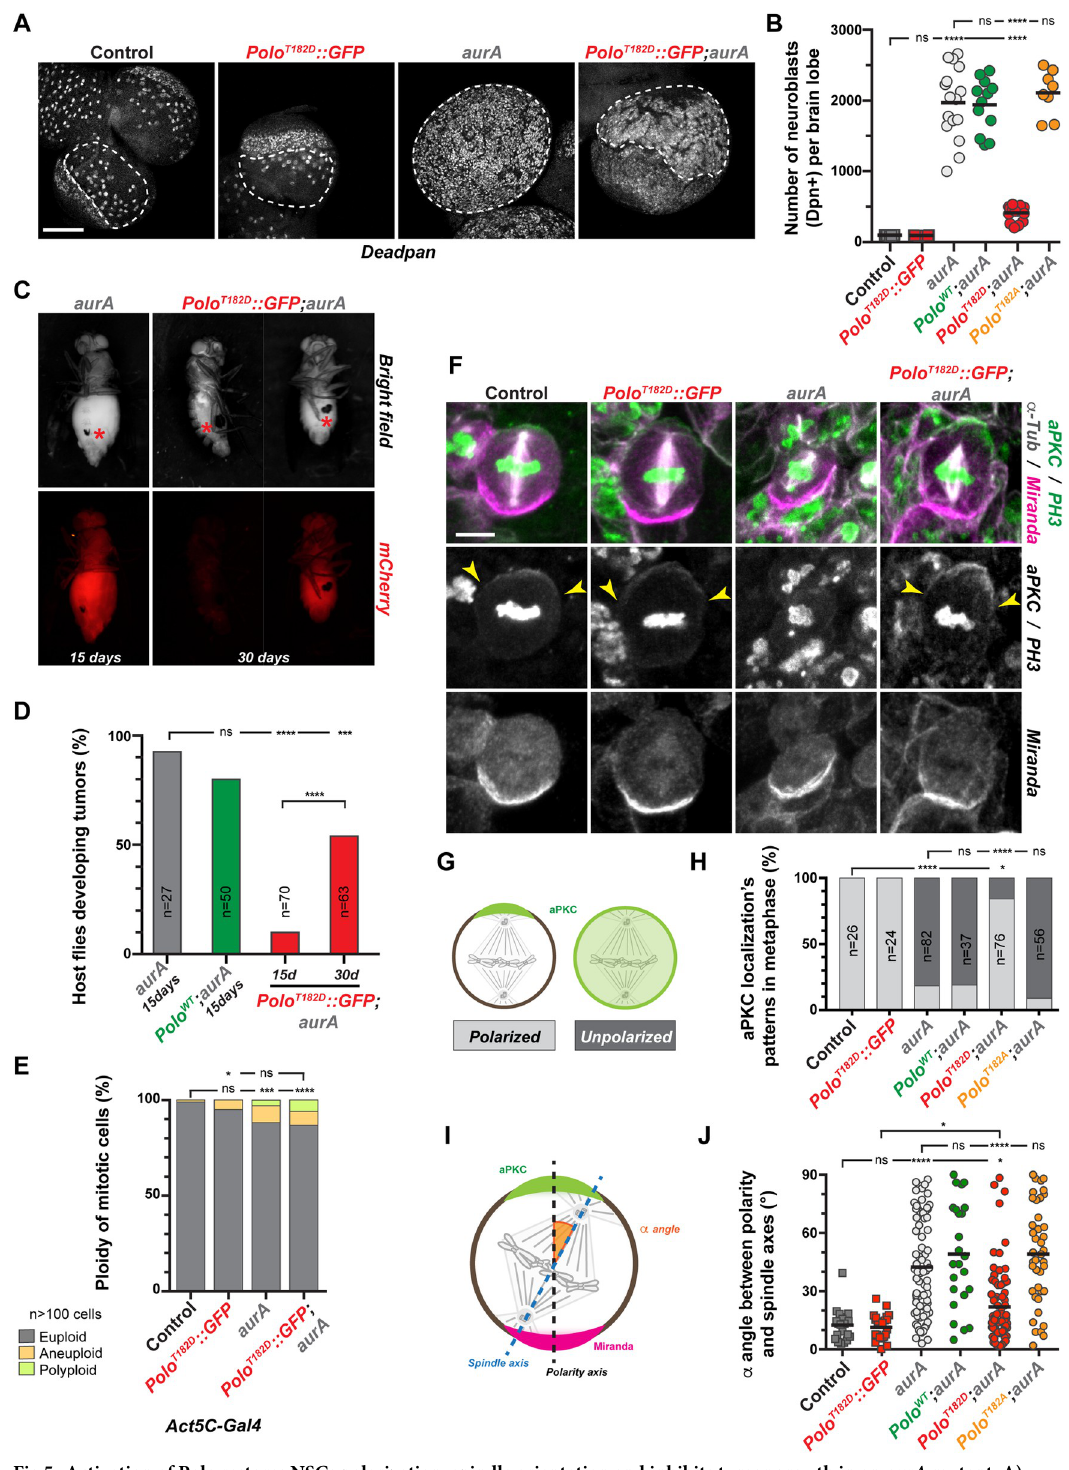
Fig 5. Activation of Polo restores NSCs polarization, spindle orientation and inhibits tumor growth in an aurA mutant. A) Representative images of fixed control and aurA mutant larval brain lobes with or without Polo T182D ::GFP expression and stained for the NSC marker Deadpan. The white dashed lines outline the central brain area where NSCs were scored. Note that the expression Polo T182D in aurA mutant restores the delimitation between the central brain and neuroepithelium. Scale bar: 100 μ m. B) Quantification of the NSC number in each brain lobe for the indicated genotypes. C) Examples of wild-type adult host flies 15 and 30